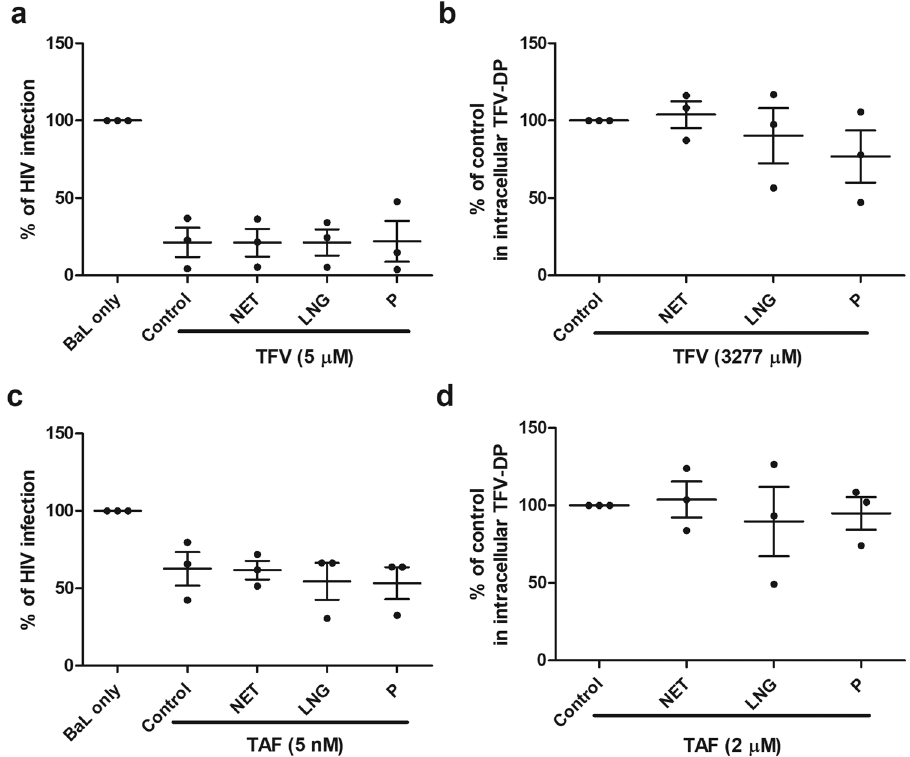
Figure 5. Lack of NET, LNG and progesterone on TFV and TAF inhibition of HIV infection of and intracellular TFV-DP concentration in blood CD4 + T cells. Activated blood CD4 + T cells were pre-treated with TFV at 5 µ M ( a ) or TAF at 5 nM ( c ) for 24 h and inoculated with HIV for 2hr. Levels of p24 released into the culture media presence or absence of NET, LNG or progesterone (P) at 1 × 10 − 7 M for 5 days following infection were measured by p24 enzyme-linked immunosorbent assay. Data were normalized to % of HIV infection with respect to infected control without TFV or TAF pre-treated and in the absence of MPA (BaL only). TFV-DP concentrations were measured by LC-MS/MS in purified blood CD4 + T cells pre-treated with NET, LNG and progesterone at 1 × 10 − 7 M for 24hr following treated with ( b ) TFV (3277 µ M) and ( d ) TAF (2 µ M) for 24 hr. Data were normalized to % fold change from control values. (Each horizontal line represents the mean and SEM from 3 individual blood donors.